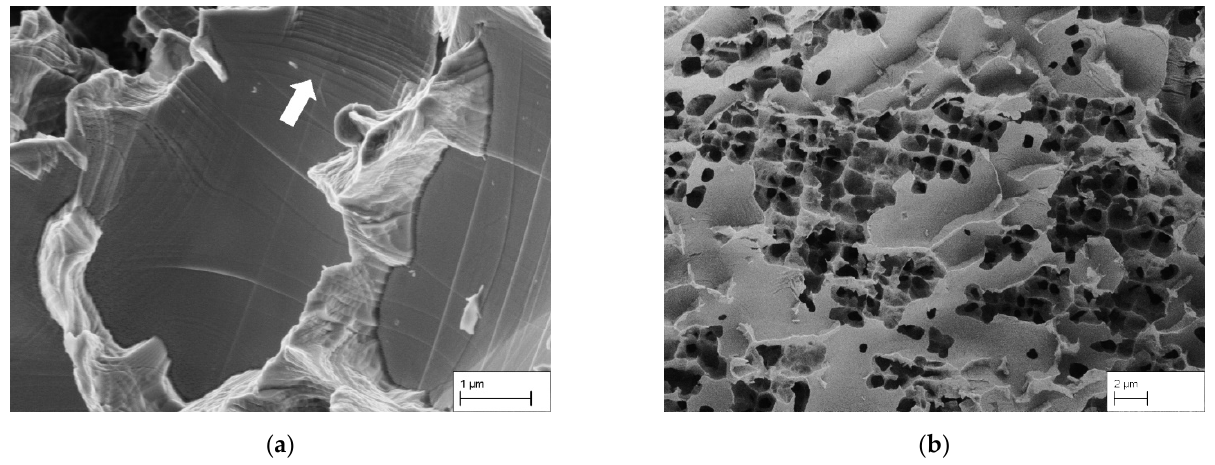
Figure 12. ( a ) Tapered ligaments with slip bands in the surrounding matrix on the fracture surface of specimen 2 (SEM image with InLens detector). ( b ) Fracture surface of specimen 5 (SEM image with Everhart-Thornley Detector for secondary electrons), visible here is the higher number of cross-links of pores from the inside of the grain to those at the grain boundary.